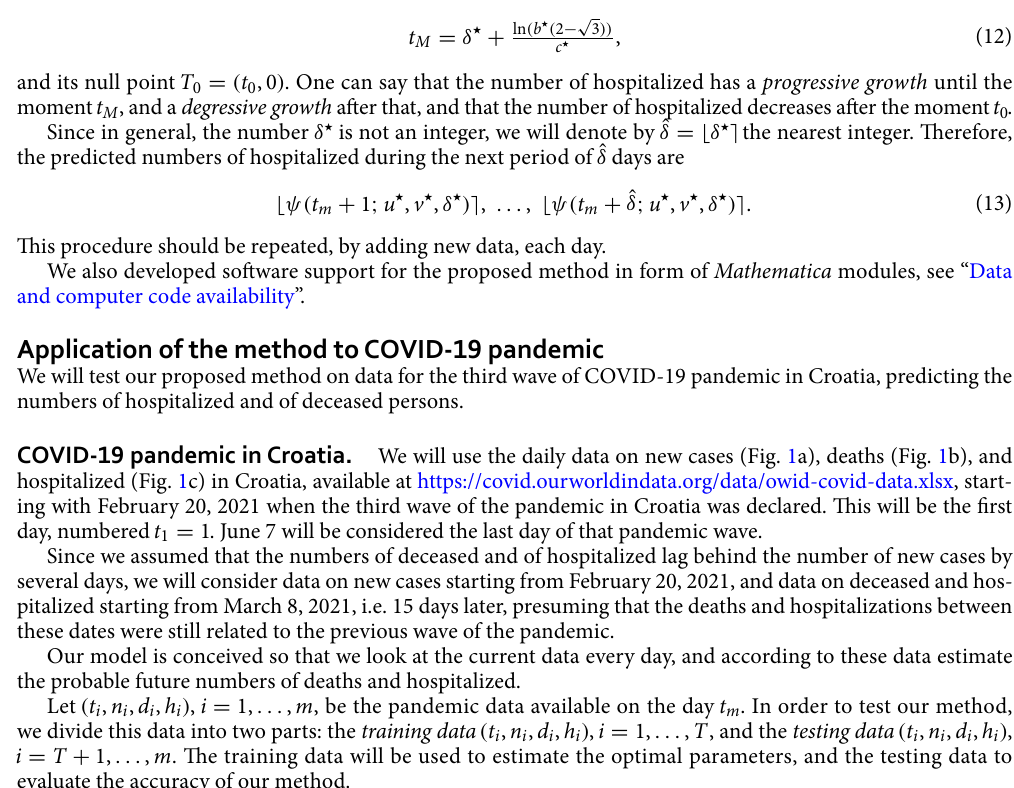
Figure 1. Daily numbers of new cases, deaths and hospitalized since February 20,